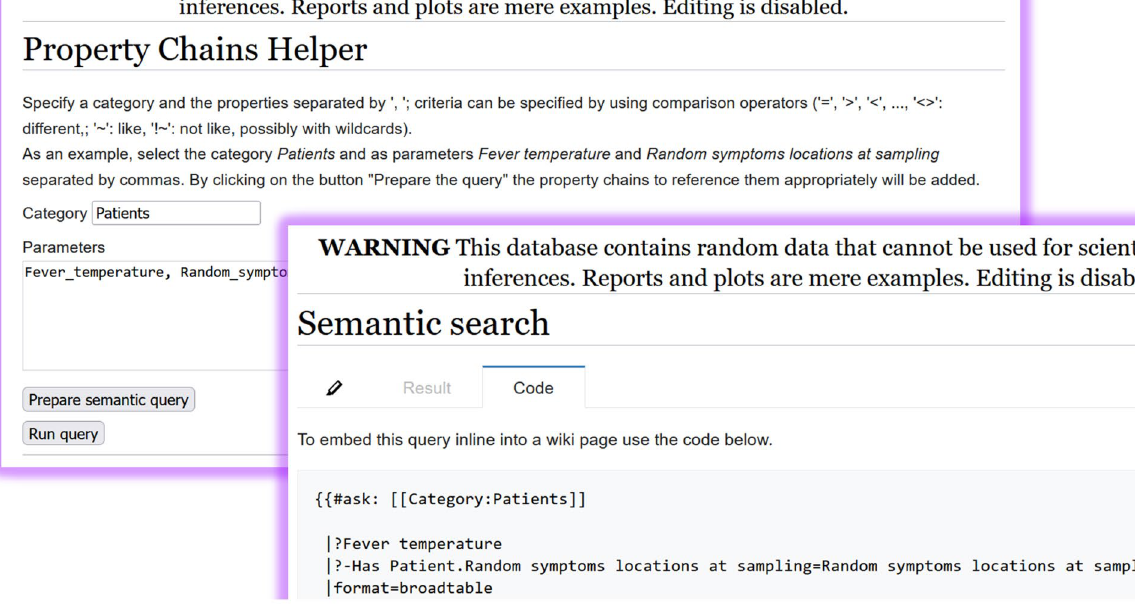
Figure 2. Property chains auto-completion: the user selects the category and the list of properties and then a semantic query can be generated complete with the correct chains, possibly inverse [Screenshots from the public demo site (see Data availability section) taken by the first